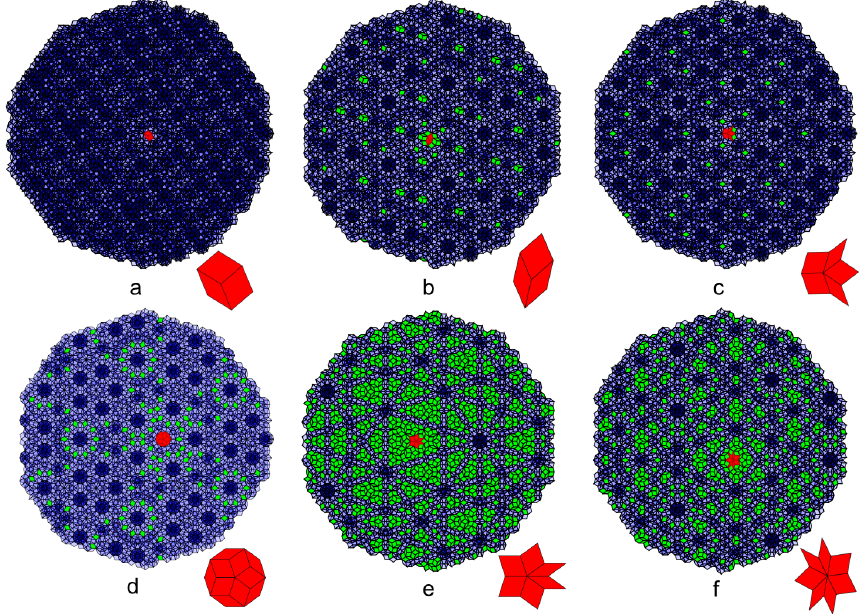
Figure 14. Results of the empire calculation of the rest of the vertex types in Penrose tiling, using the cut-and-project method. For each vertex type, an enlarged center vertex configuration is shown at the lower right corner of its